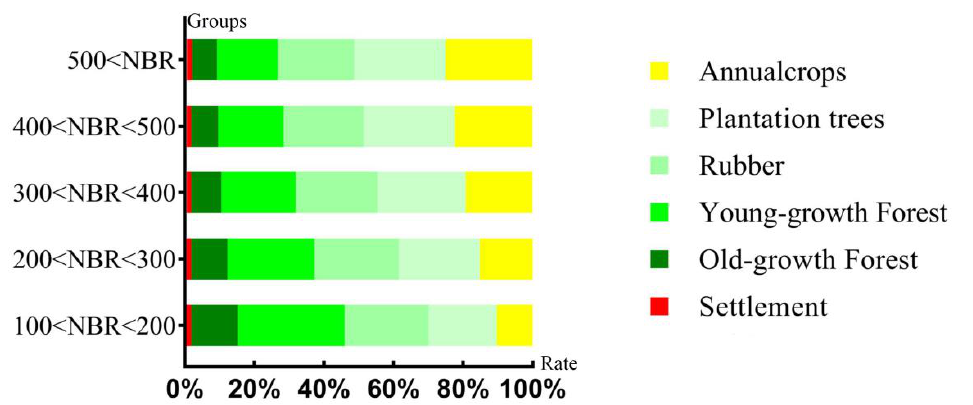
Figure 9. The quantitative relationship between land use volatility and the latest land use/cover types. We have removed the bare land and waterbody as they were almost absent.